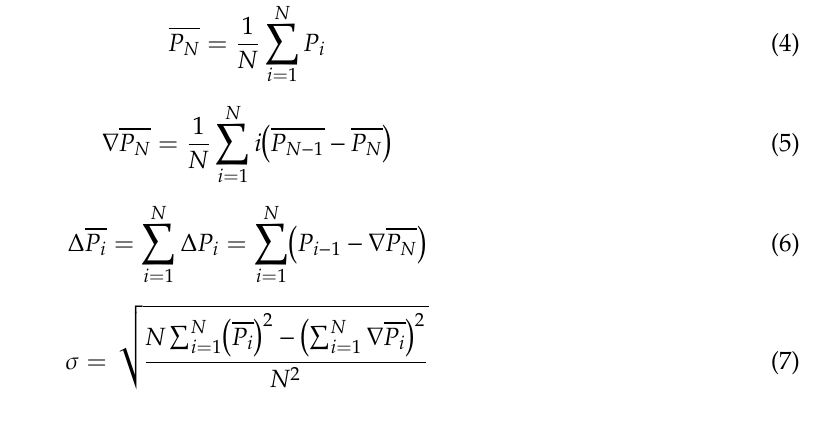
Table 3. Probability value corresponding of the data